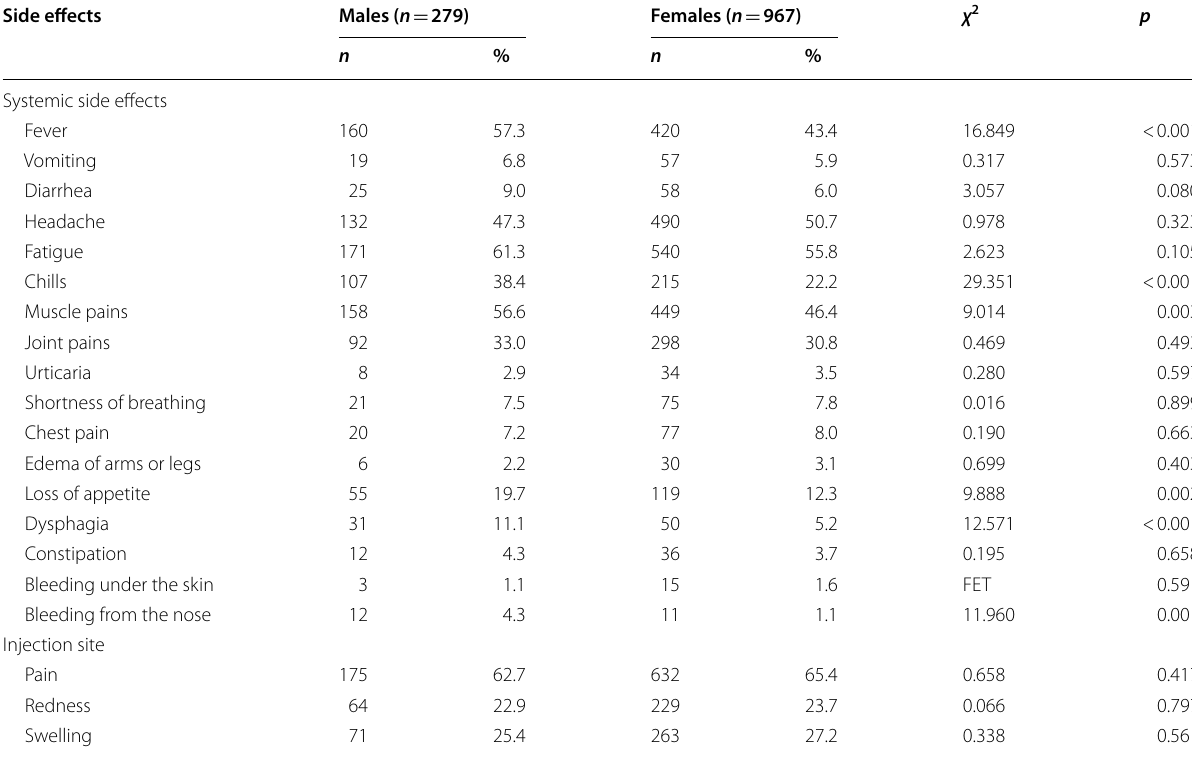
FET Fisher’s Exact test